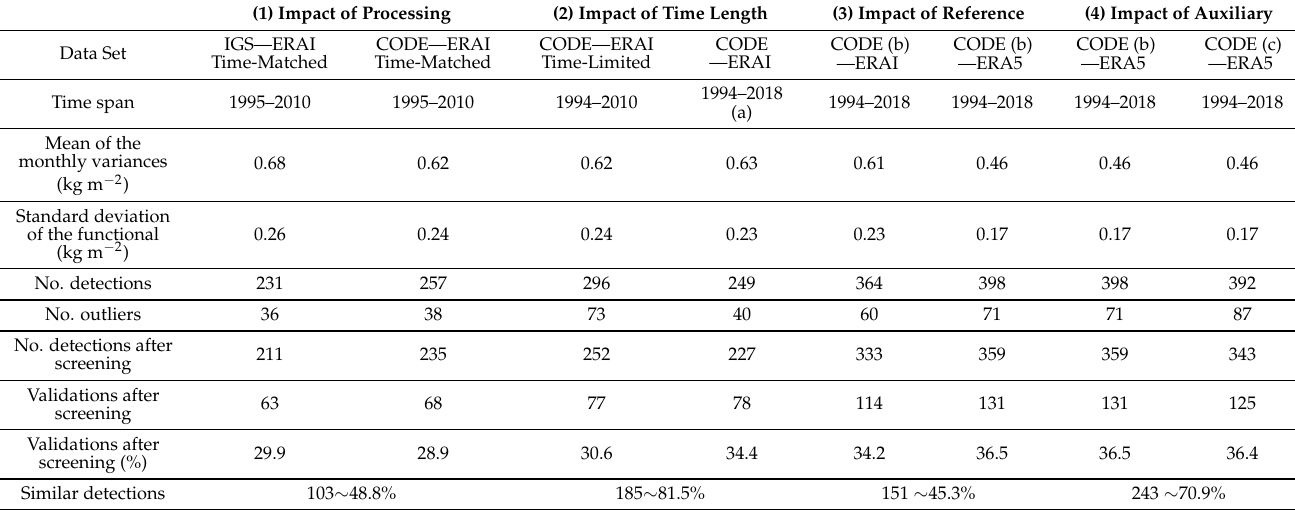
Table 2. Summary of pairwise comparisons of segmentation results from various data sets used in this work. The validation with respect to GNSS metadata and the similar detection statistics used a closeness window of ± 62 days. (a) Segmentation is run over the full time series (1994–2018), but change-points are compared for the time-limited period (1994–2010). (b) This CODE data set uses auxiliary data from ERA5. (c) This CODE data set uses auxiliary data from